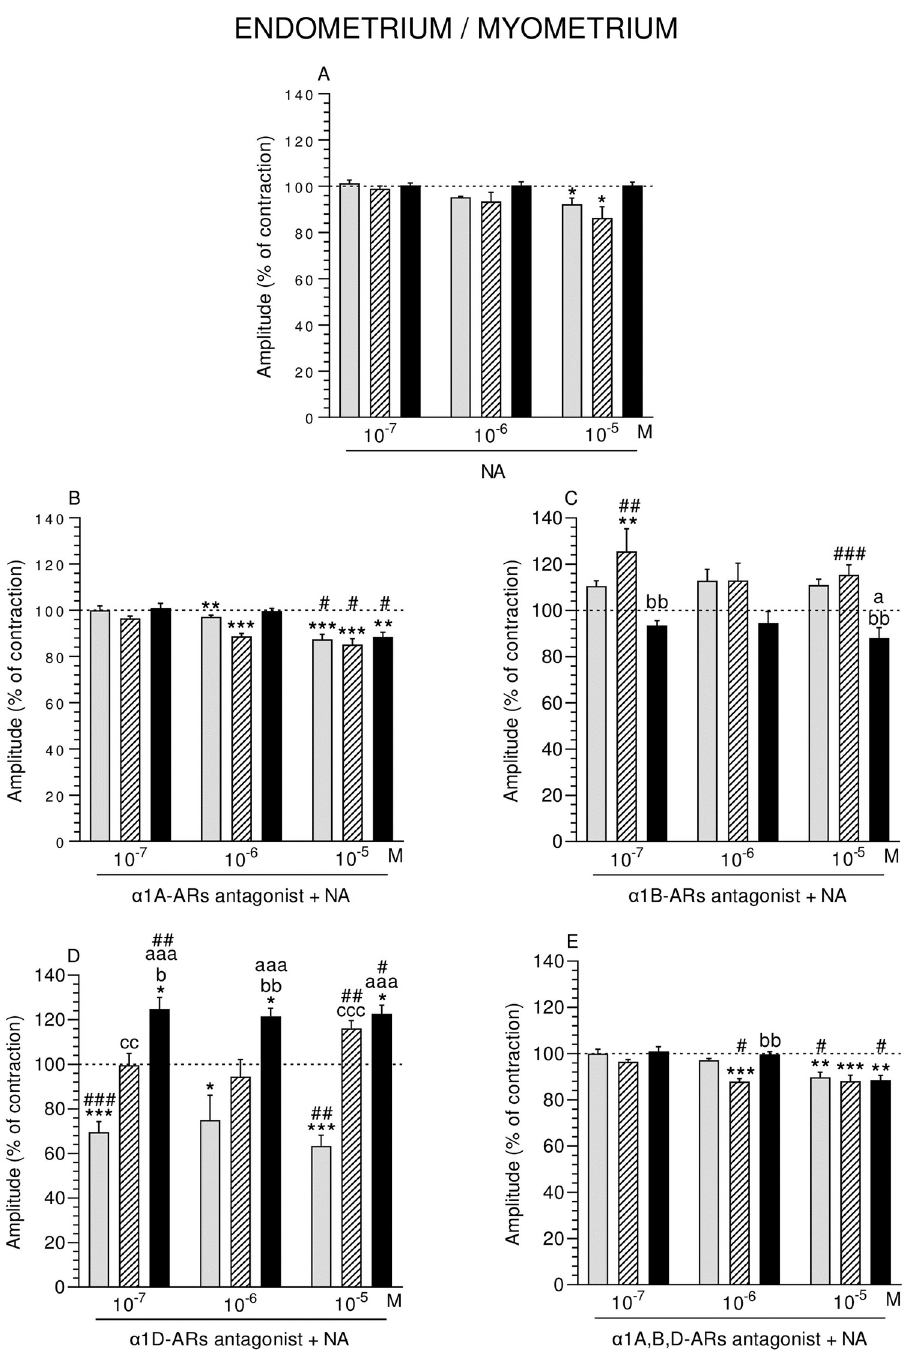
Fig 5. Effect of noradrenaline (NA) alone (A) and NA with α 1A- (B), α 1B- (C), α 1D- (D) and α 1A,B,D (E)– adrenoreceptors (ARs) antagonists (a dose of 10 − 4 M) on the amplitude of contractions in pig endometrium/ myometrium strips obtained from the CON (grey bars), SAL (hatched bars), and E . coli (black bars) groups. Data from five experiments (gilts, in each group). Effects of particular doses of NA and antagonists are expressed as percentage (mean ± SEM) in relation to the basal (pre-treatment period) contractile amplitude, established as 100% (horizontal lines). � P < 0.05, �� P < 0.01, ��� P < 0.001—indicate differences from baseline in each group; a P < 0.05, aaa P < 0.001- indicate differences between CON and E . coli groups for the same treatment; b P < 0.05, bb P < 0.01, bbb P < 0.001—indicate differences between SAL and E . coli groups for the same treatment; cc P < 0.01, ccc P < 0.001— indicate differences between CON and SAL groups for the same treatment; # P < 0.05, ## P < 0.01, ### P < 0.001 compared between particular antagonist with NA effect versus NA effect alone for the same group/NA